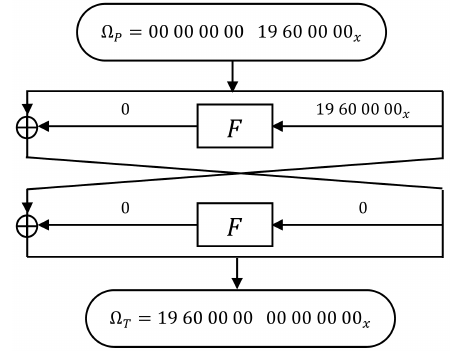
Figure 18: The Iterative Differential Characteristic of DES (Ω 1